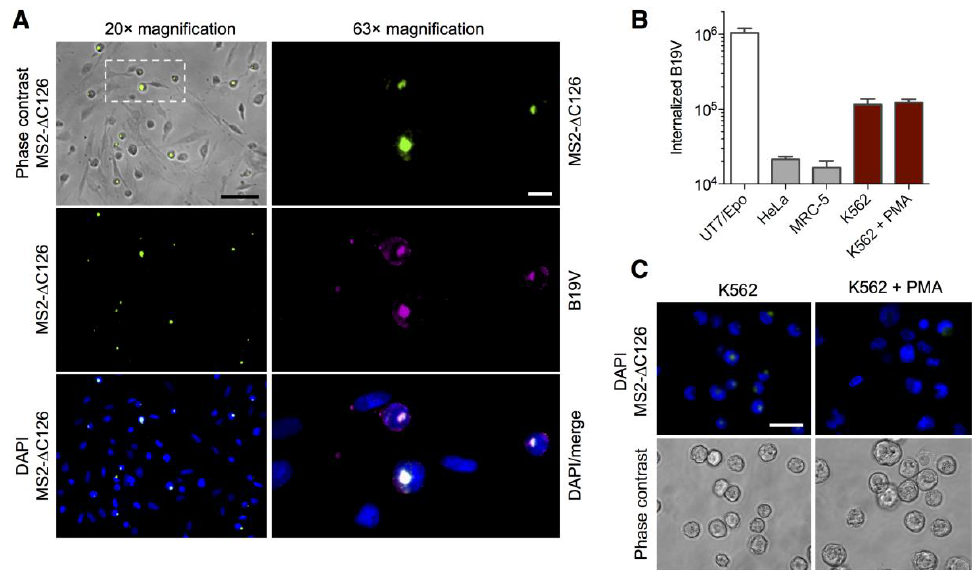
Figure 3. Native B19V and MS2-VP1u specifically target erythroid cell lines. ( A ) MS2- ∆ C126 VP1u and native B19V were incubated with the same mixed cell culture of non-adherent UT7/Epo cells, and adherent HeLa and MRC-5 cells. Cells were fixed and immunostained with an anti-B19V capsid antibody (860-55D [33]). Cell-specific internalization of MS2- ∆ C126 VP1u (green) and native B19V (magenta) was visualized by fluorescence microscopy. Scale bar: 100 µ m (20 × magnification), 15 µ m (63 × magnification); ( B ) Cellular uptake of native B19V into the different cell lines measured by qPCR ( n = 3); ( C ) Internalization of MS2-VP1u on normal and phorbol myristate acetate (PMA)-differentiated erythroleukemic K562 cells, visualized by fluorescence microscopy. Scale bar: 30 µ m (63 ×